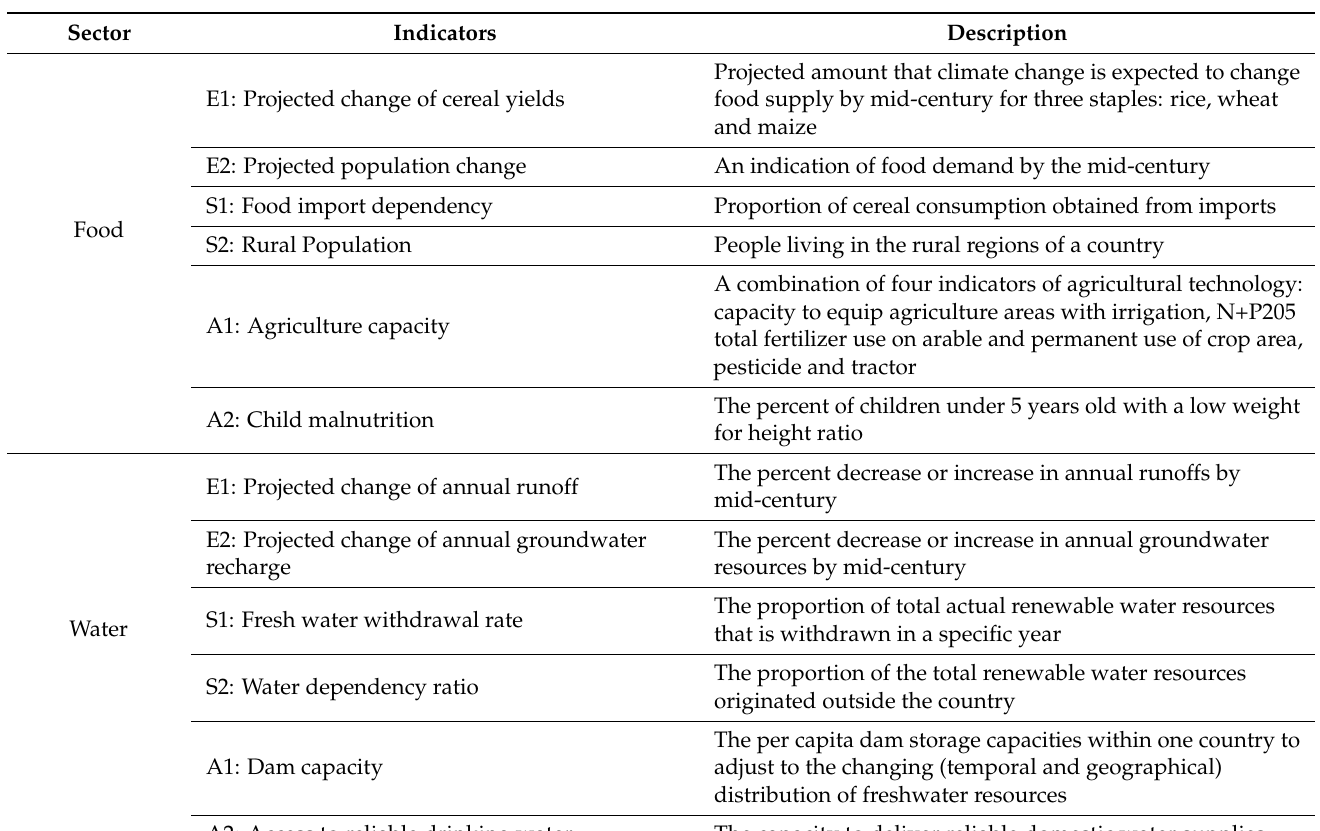
Table 1. Vulnerability Indicators.